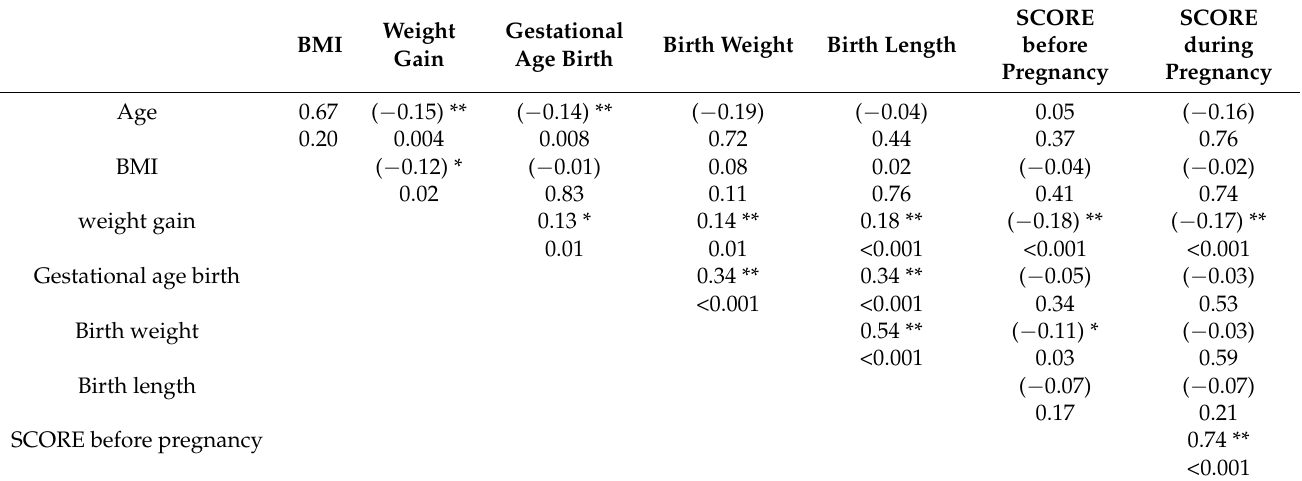
Figure 3. Gestational weight gain in women with low, medium, and high adherence to MD. In Table 4, the relationships among the variables are reported. An inverse correlation was found between GWG and MEDAS score pre- and during pregnancy ( p < 0.001 for both). GWG was also positively correlated with neonatal weight and length ( p < 0.05 and p < 0.001, respectively). Table 4. Correlation between neonatal and obstetric outcomes and MEDAS in uncomplicated women ( n = 366).